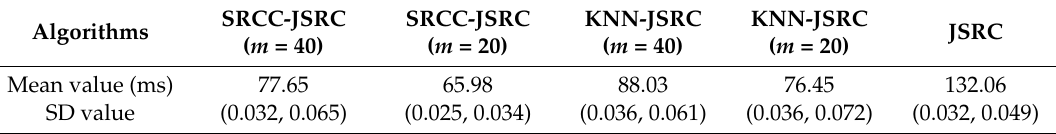
Figure 4. Comparative results of computation time from the different JSRC-based gait-classification algorithms. Table 4. The statistical results for the lowest computation time from all selected algorithms.